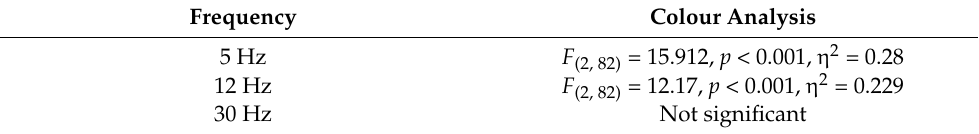
Table 3. Simple effects of the color variable on SNR for the 1st harmonic, for the three frequencies.